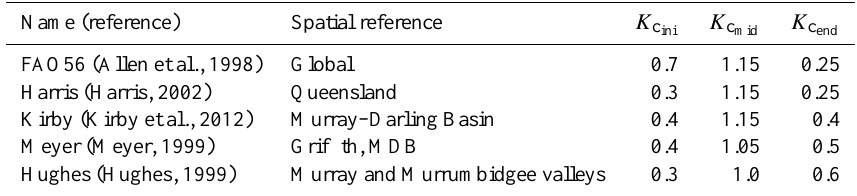
Table 1. The five crop parameter sets for K c .